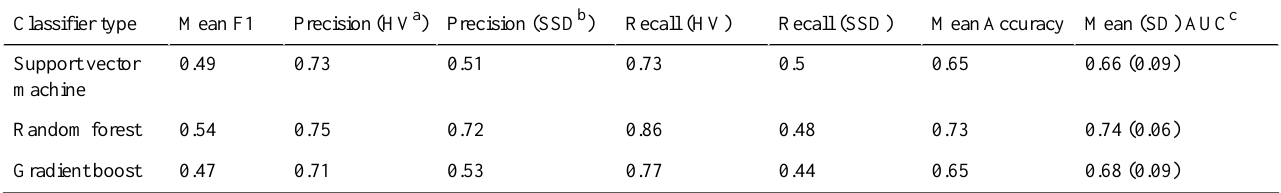
Table 3. Diagnostic classifier